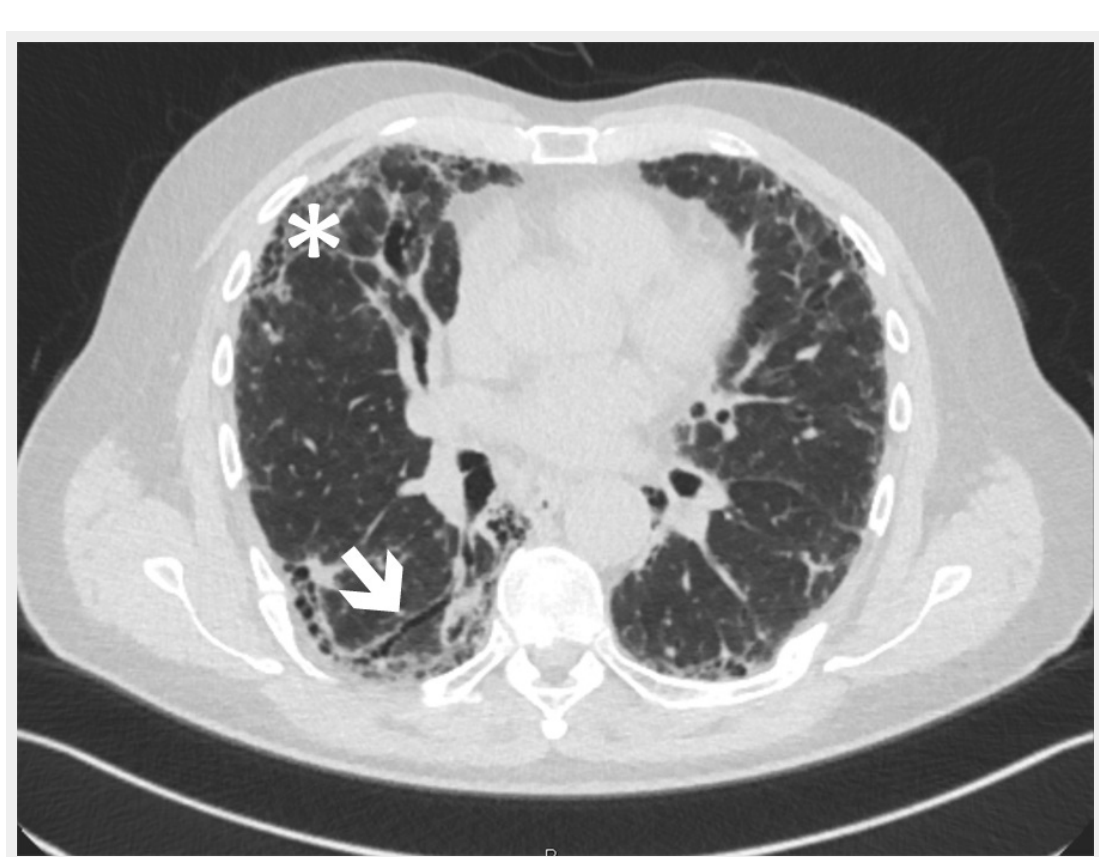
Figure 1 Chest computed tomography scan of a patient with idiopathic pulmonary fibrosis. Typical radiological pattern of usual interstitial pneumonia with traction bronchiectasis (arrow) and subpleural honeycombing (star) is